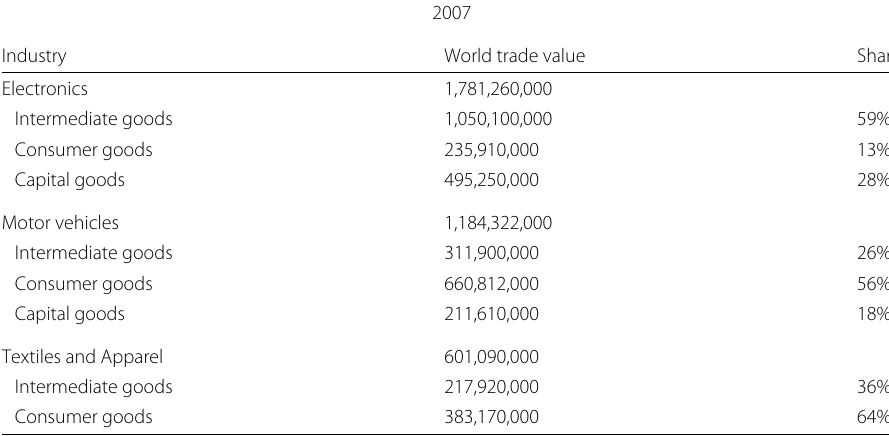
Table 1 USD values (current prices) and share of intermediate, consumer, and capital goods in the Electronics, Motor Vehicles, and Textiles and Apparel industries in